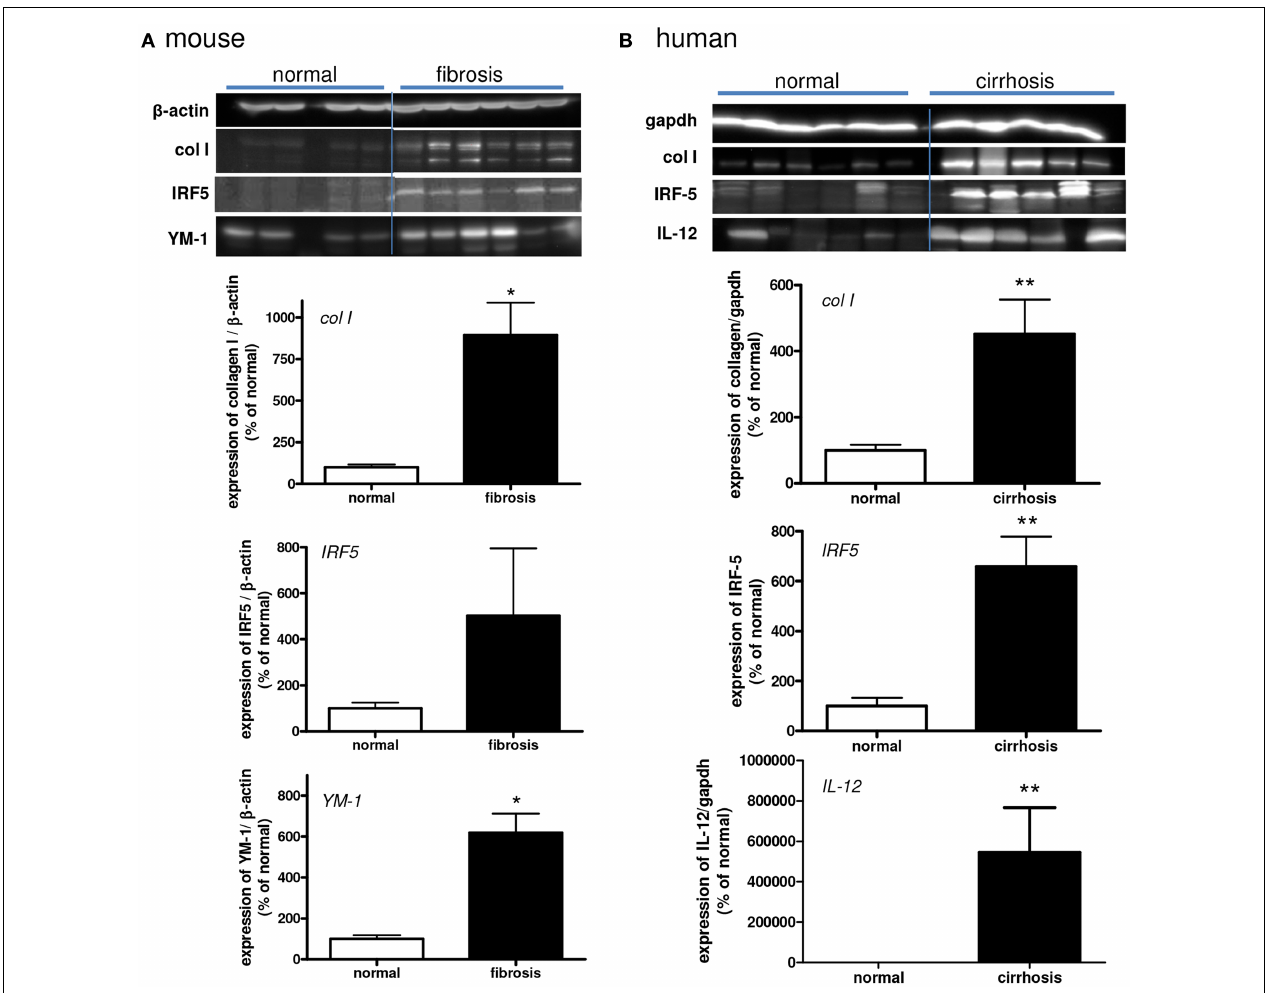
FIGURE 4 |Western blot analysis of the expressions of collagen type I, IRF-5 (M1), IL-12 (M1), andYM-1 (M2) in normal and fibrotic mouse (A) and human (B) livers . * p < 0.05. N = 5 cirrhotic human livers, N = 6 normal human livers, N = 4 normal mouse livers, N = 6 fibrotic mouse